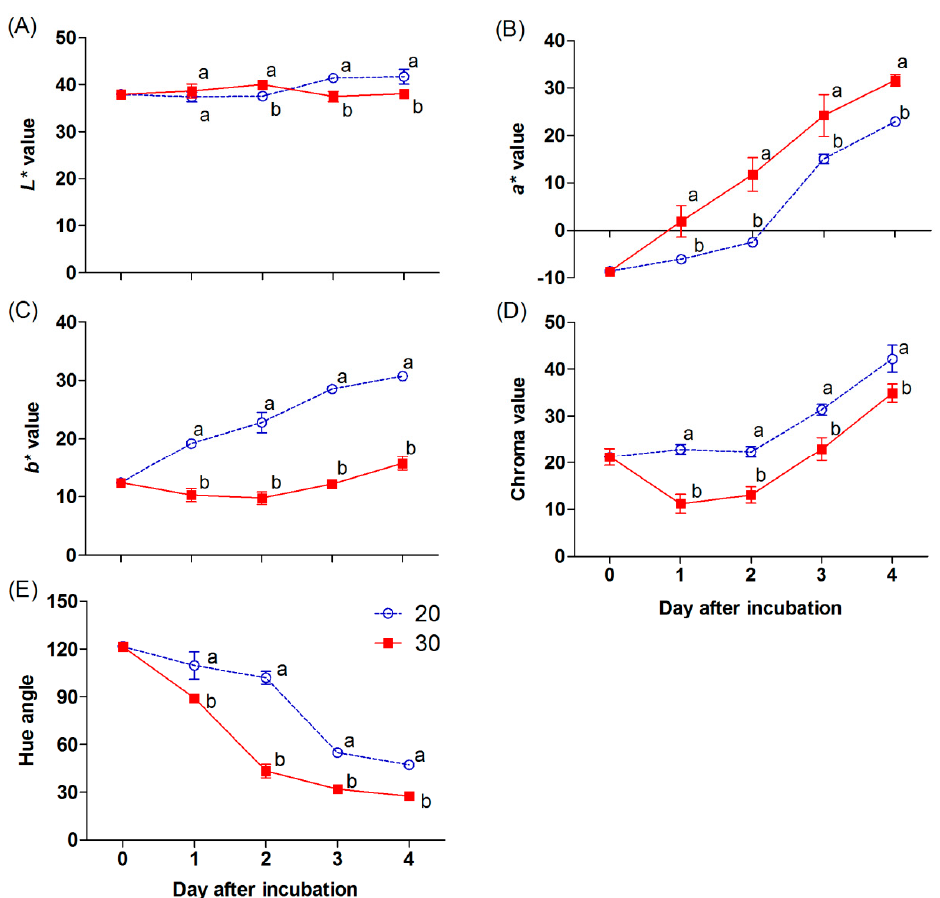
Figure 3. E ff ect of incubation temperatures at 20 and 30 ◦ C on the L*, a*, b*, chroma, and hue angle ( A − E ) of “Takanotsume” chili for 4 days. Values are means ± SD ( n = 3). Di ff erent letters indicate a significant di ff erence between temperatures on the same day of incubation ( p ≤ 0.05).